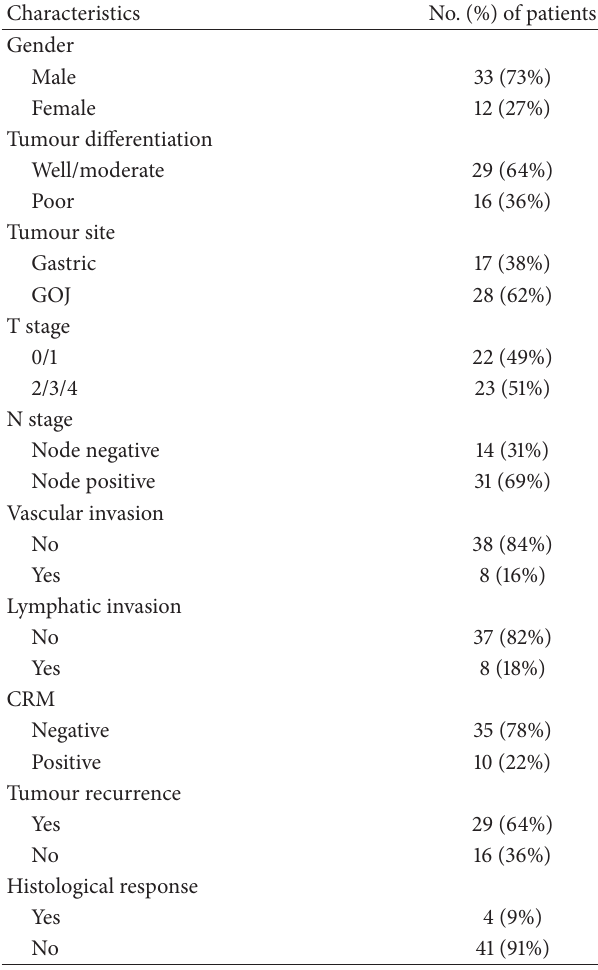
Table 1: Patient